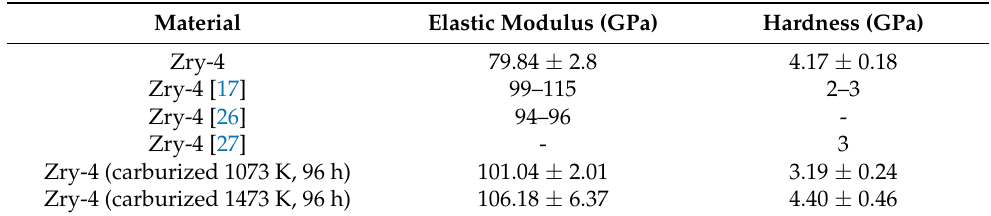
Figure 5. K p versus 1/T based on the data from Figure 3. Table 3. Summary of elastic modulus and hardness values as obtained from nanoindentation tests on as received Zry-4 and carburized